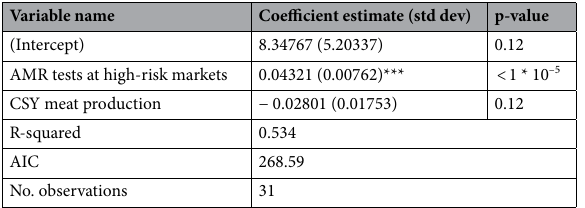
Table 3. Linear regression—model coefficients. Standard errors are reported in parentheses. *, *** indicates significance at the 90% and 99% level,